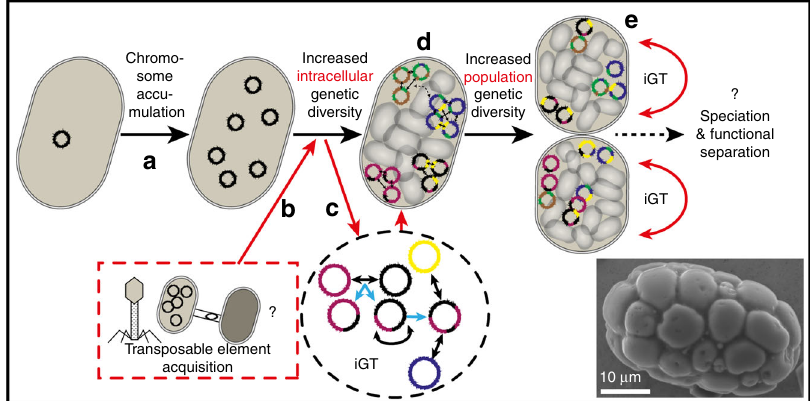
Fig. 8 Proposed model for generation of large intracellular and subsequent population genetic diversity. Genome replication in an ancestral Achromatium cell a is followed by the acquisition of an unusually high number of transposases via undetermined mechanisms (e.g., phages, horizontal gene transfer); b . The genomes in the polyploid cell undergo a process of intracellular gene transfer (iGT) with limited transfer between cell parts c due to the multiple calcite bodies which can be seen in the insert. The new chimeric genomes further interact increasing the cellular diversity while maintaining conserved regions such as operons intact c . Overall this results in a cell with multiple different chromosomes; d . represented by the different colors of each chromosomes. Gene conversion does not occur on a cellular level but maintains genome stability at a local scale and thus fi xing multiple version of the same gene in different cellular locations. A dividing cell recruits part of the genomic material generating two daughter cells different from each other as well as from the mother cell; e . Scale bar in SEM insert is 10 µ